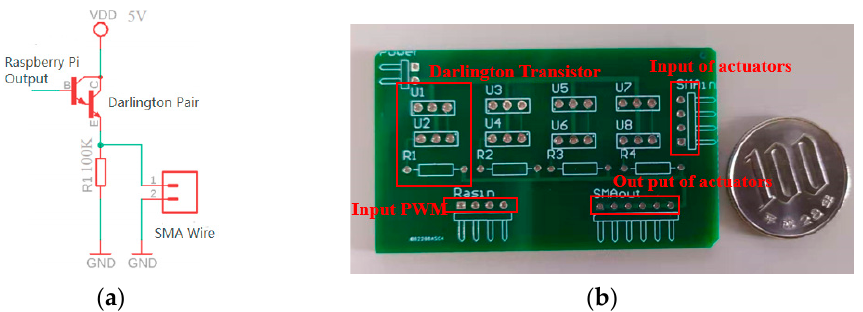
Figure 7. Current amplifier circuit. ( a ) Darlington transistor current amplifier. ( b ) Outlook of driving board.